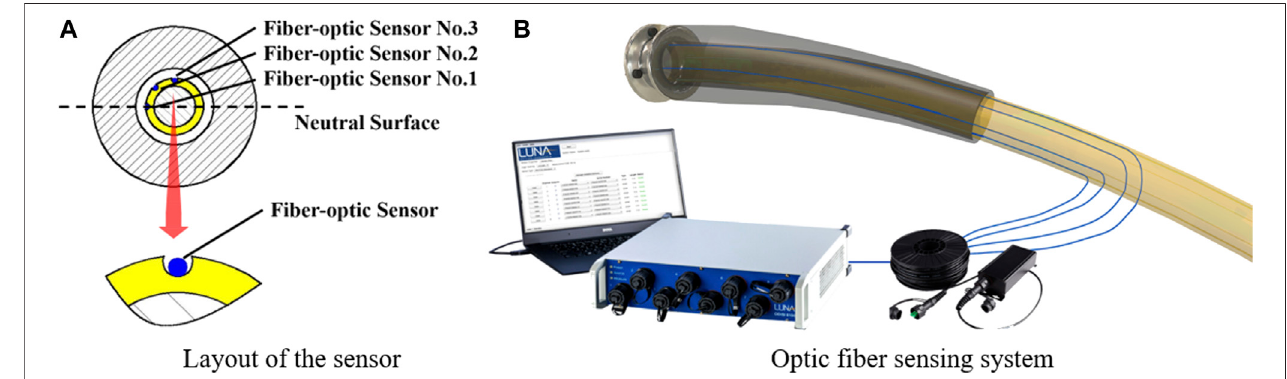
FIGURE 5 | Layout of the Fiber-optic sensor and